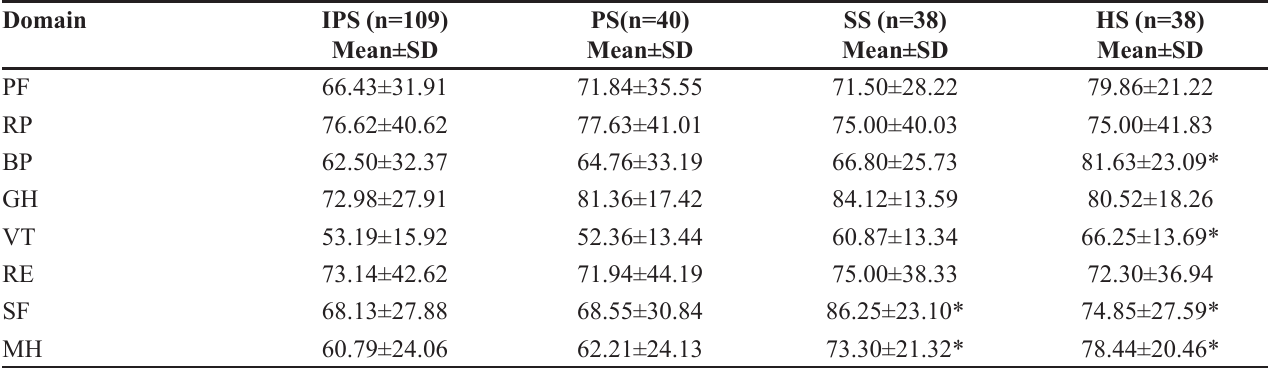
TABLE II - Mean (±SD) scores of quality of life (SF-36), stratified by education level, of participants in companionship groups, Porto Alegre/RS